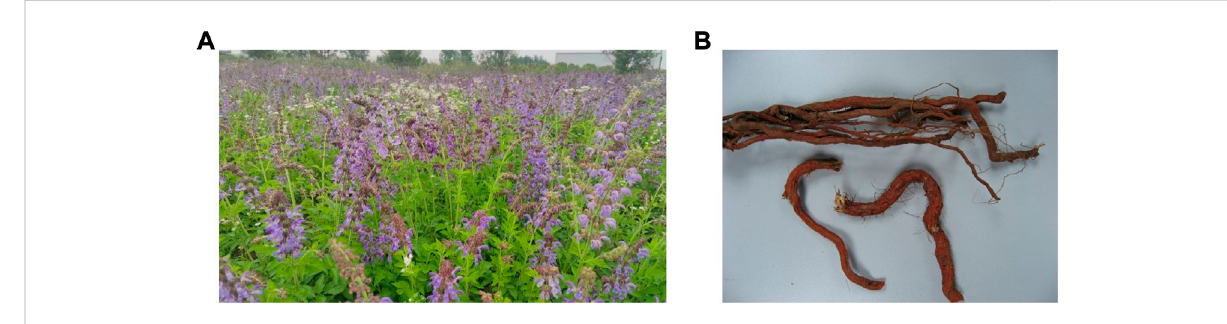
FIGURE 1 Overall appearance of Salvia miltiorrhiza Bunge (SM). (A) The aerial parts of SM. (B) The raw herb of